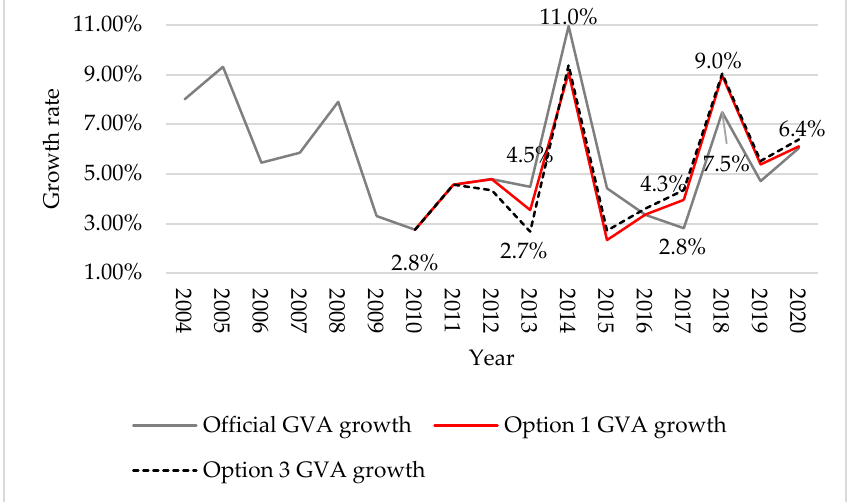
Figure 7. Canterbury economic activity: GVA (NZD/millions), 2005–2020. Source : (MBIE 2021) and author’s calculations.